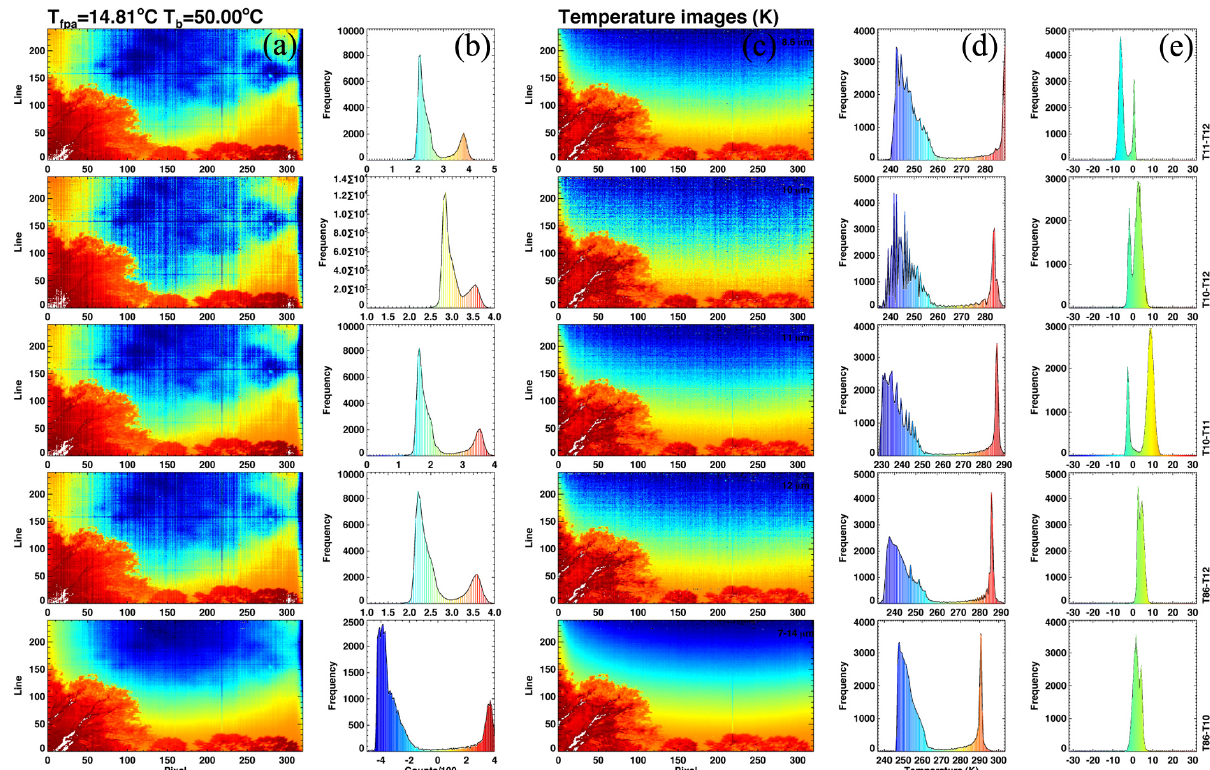
Figure 4. Cyclops spectral images obtained at an SO 2 -free, particulate-free site in Australia. (a) Panels showing uncalibrated data (DNs or counts), (b) their respective histograms, (c) panels showing calibrated images, (d) their histograms, and (e) histograms of selected temperature differences. The order of the images starting from the top is 8.6, 10, 11, 12µm and the broadband (7–14µm)